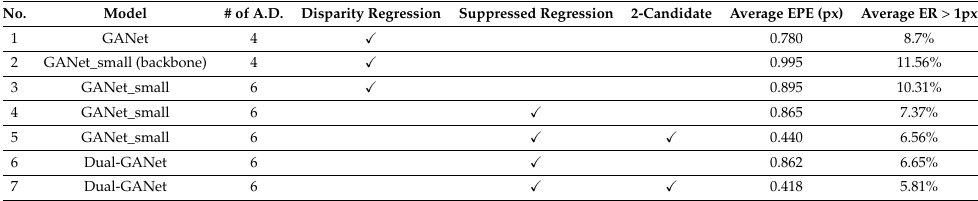
Table 1. Evaluation and comparison using the SceneFlow dataset. The number of aggregation directions is denoted as # of